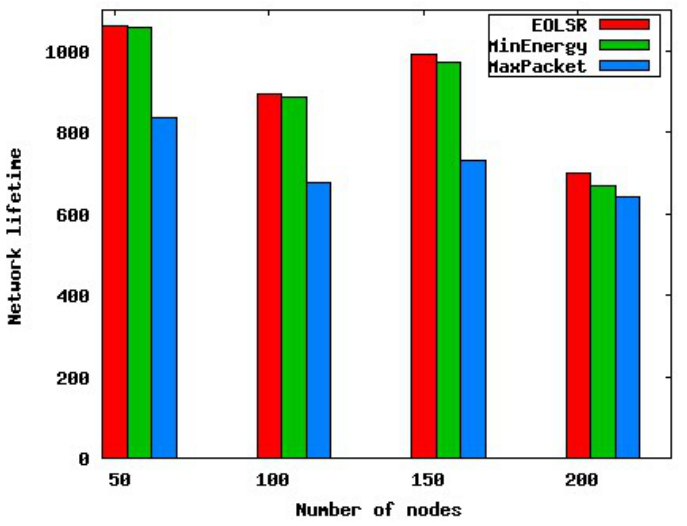
Figure 2. Network lifetime obtained with EOLSR, MinEnergy and